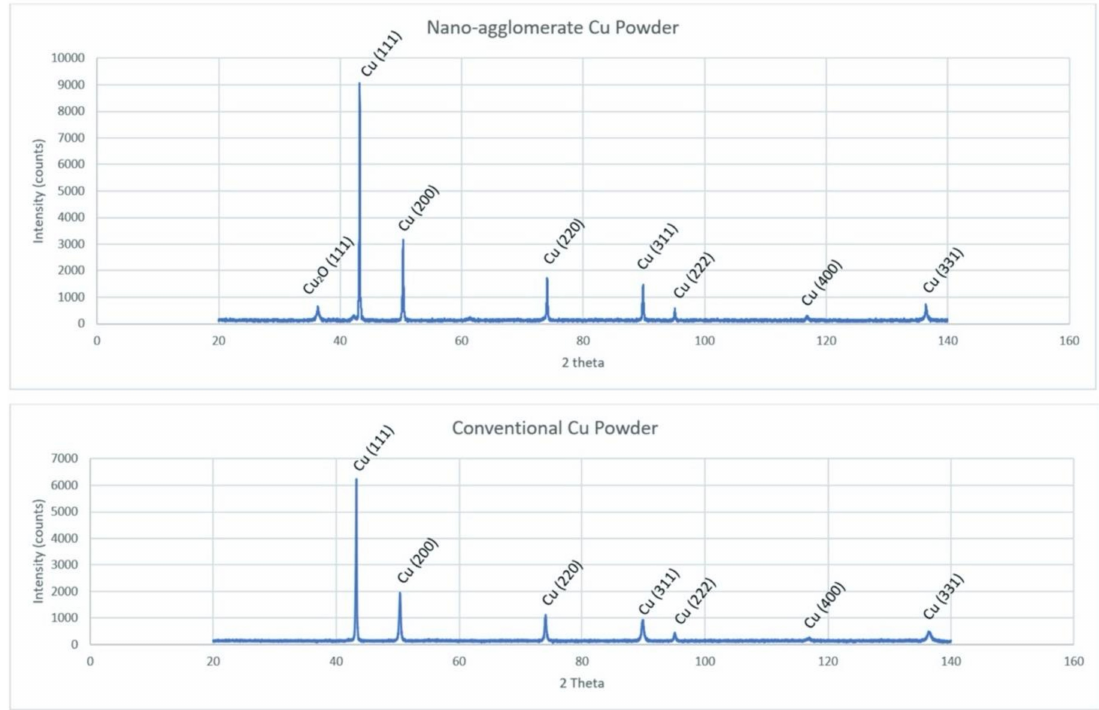
Figure 8. Powder X-ray di ff raction (PXRD) of the spray-dried Cu powder ( top ) and GA Cu powder ( bottom